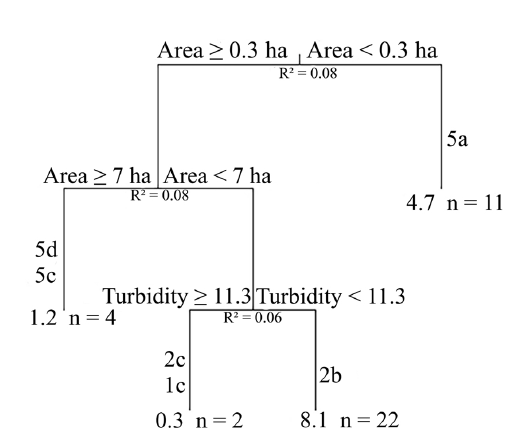
Figure 4. MRT model based on morphofunctional groups (MFG) densities and local predictors of the 40 reservoirs in the rainy season (R 2 = 0.22). n is the number of sample units; the number on the left is the sum of the squares of the errors in each group. Each MFG group shown contributed most to the explanation of each group. The measurement unit of turbidity is NTU. Error = 0.7, CV Error = 1.2, SE = 0.09. Data used from Silva et al.